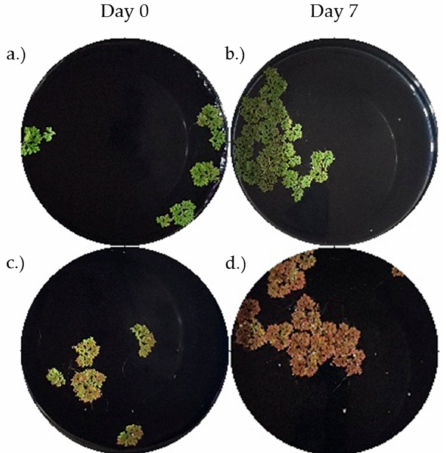
Figure 3. Photographs of the A. pinnata were taken throughout the experiment. These images demonstrate a comparison of the 15% strength Hoagland solution (image ( a , b )) and the 100% strength IRR2 medium (image ( c , d )). All other growth conditions were constant: nitrogen was present, no pH control, medium light intensity (10,000 lx), and 75% humidity. It was concluded that the Hoagland solution was better suited to healthy plant growth due to the consistent green colour compared to the red-brown colour produced by the IRR2 growth medium, which indicated that the plant was